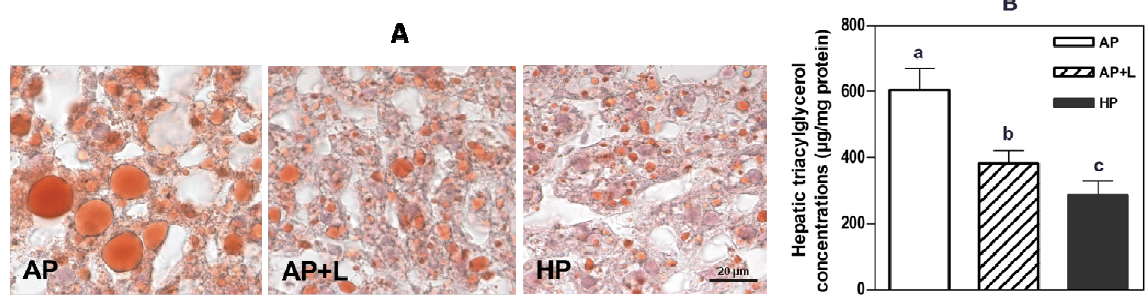
Figure 5. Oil red O staining of livers ( A ) and hepatic triacylglycerol concentrations ( B ). Ten weeks old male C57BL/6 mice were fed for 20 weeks ad libitum with experimental semisynthetic high-fat diets (20% w / w of fat) containing different protein and leucine concentrations. AP, adequate protein (10% w / w of whey protein); HP, high-protein (50% w/w of whey protein); AP + L, AP supplemented with L -leucine corresponding to HP (+6% L -leucine). Data are means ± SEM, n = 9–10, “a, b, c” indicates that “ p < 0.05”